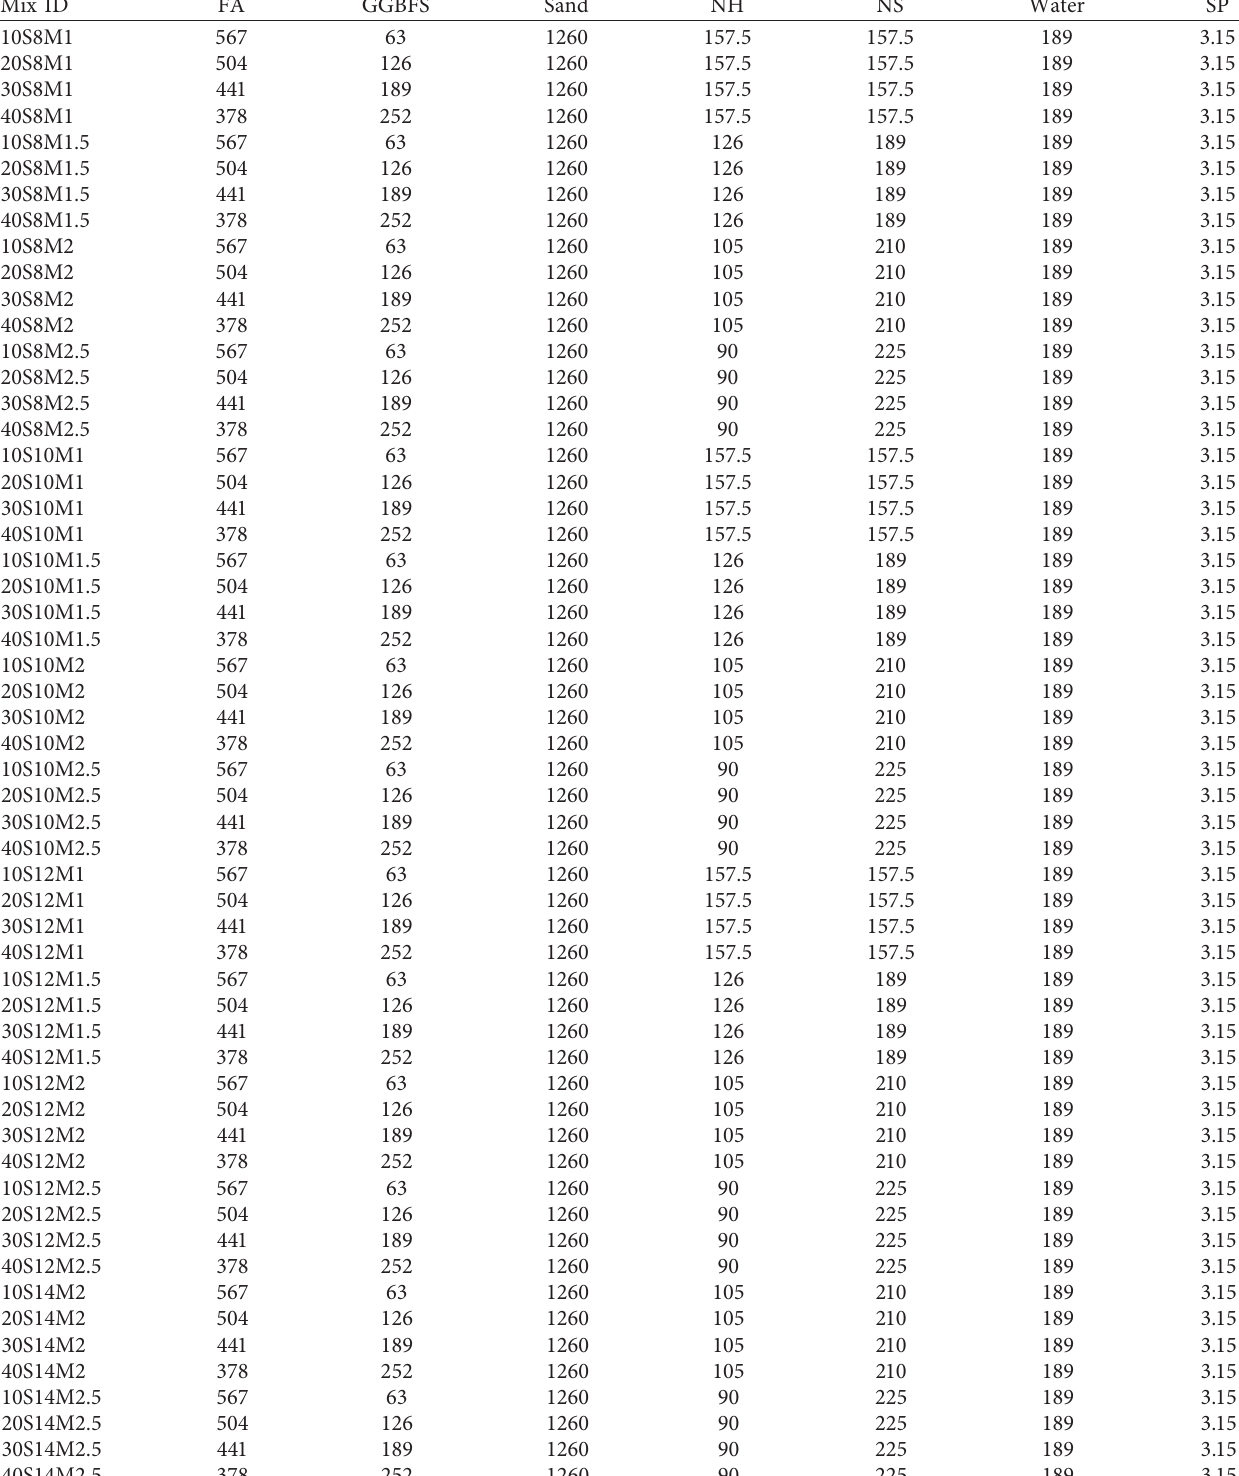
Table 3: Mix proportion details of geopolymer mortar (kg/m 3